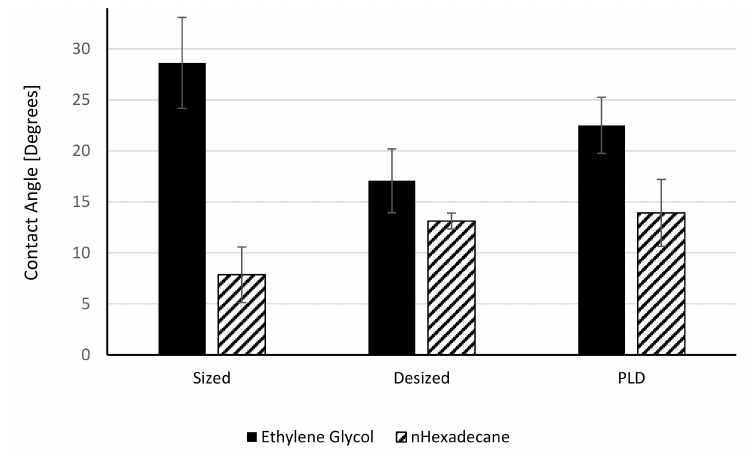
Figure 12. Contact angles of desized fibres after SWCNTs deposition.